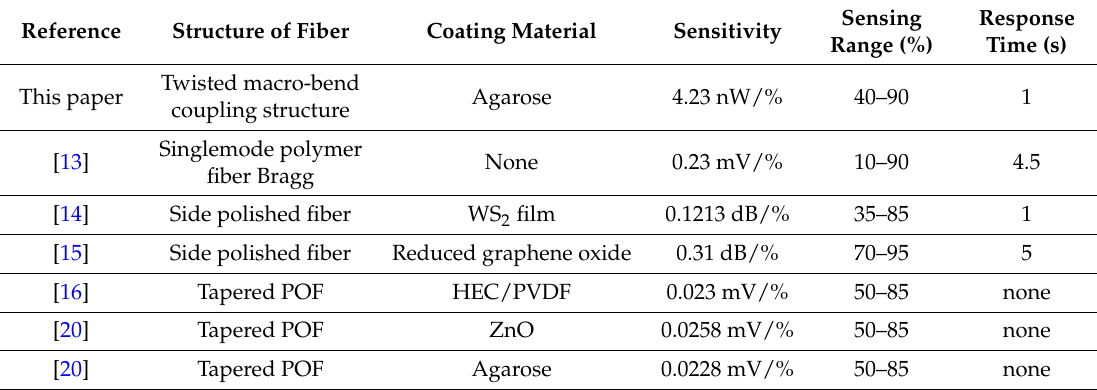
Table 2. Comparison between the proposed sensor and the cited RH